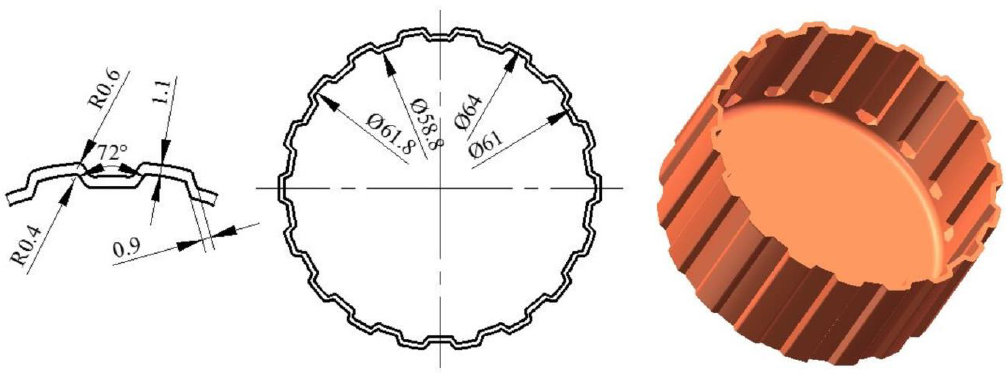
Figure 1. Clutch hub geometry dimensions (unit: mm).